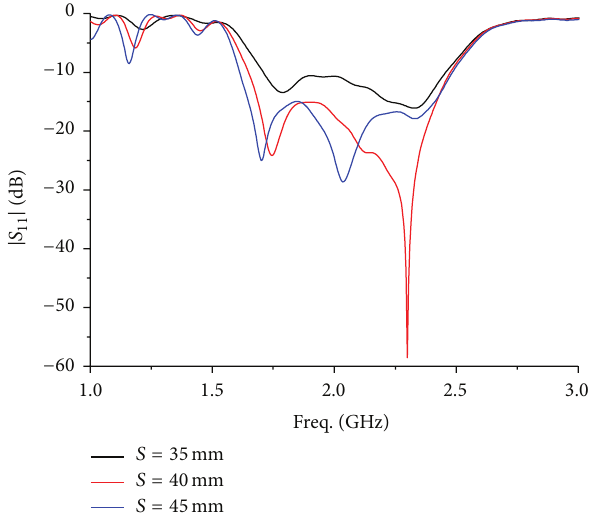
Figure 2: The effect of the loading metal strip length ( S ) on the antenna reflection coefficient.